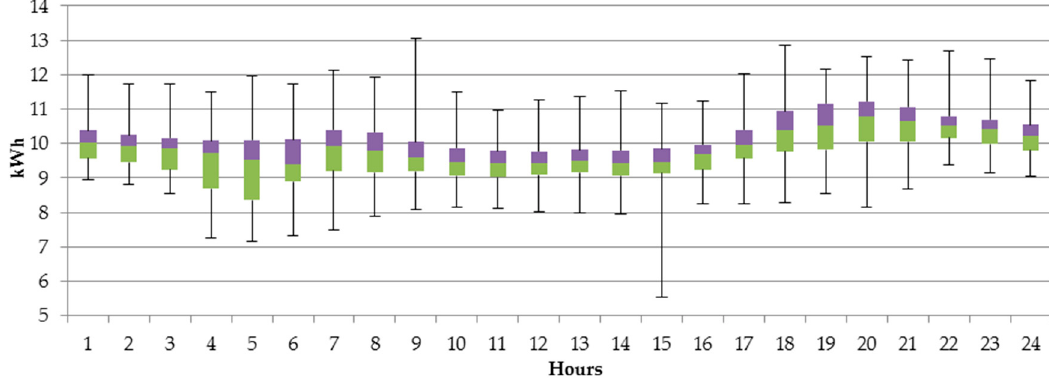
Figure 3. Customer with the least volatile consumption (in kWh) in the analyzed period (January– December 2015).